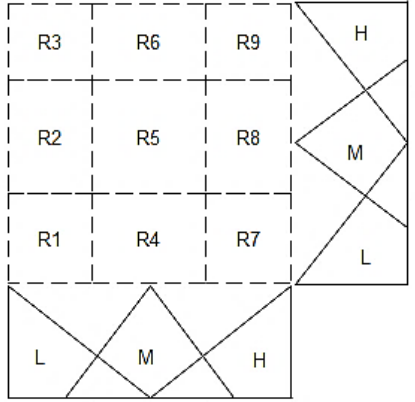
Figure 8. Decision region of the fuzzy rule without CF.